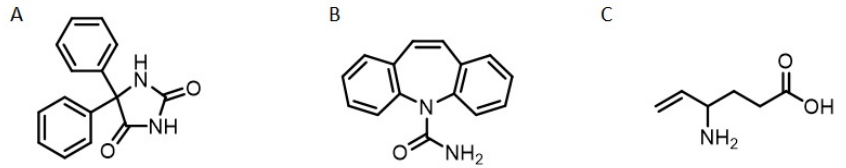
Figure 1. Chemical structure of clinical used anticonvulsant drugs in clinical use. ( A ) Phenytoin, first generation; ( B ) Carbamazepine, second generation, and ( C ) Vigabatrine, third generation.